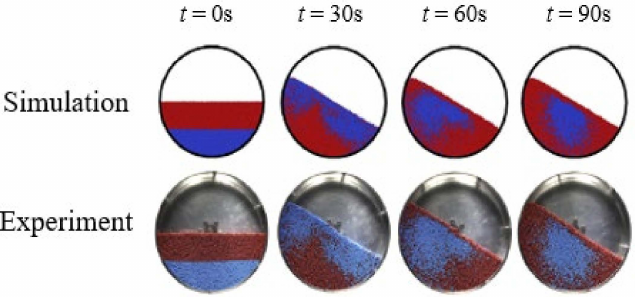
Figure 7. Simulation and test diagram of rotating cylinder mixing